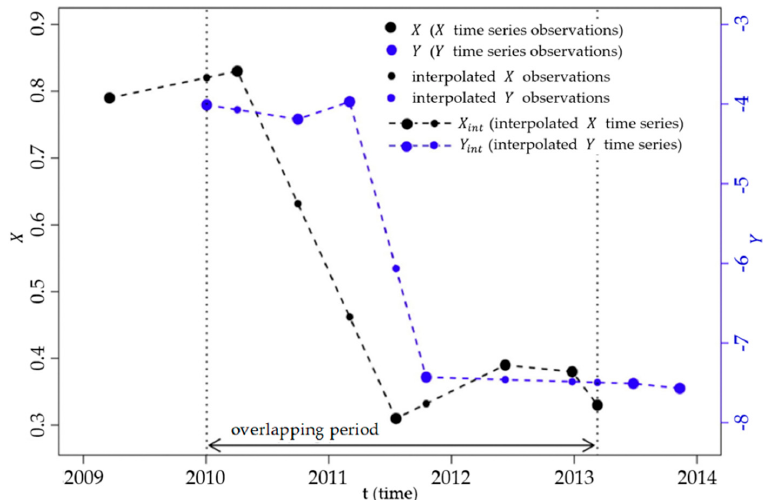
Figure 3. Original and interpolated hypothesized time series (adapted from Figure 4 on page 281 in the paper by J. Reiche et al.